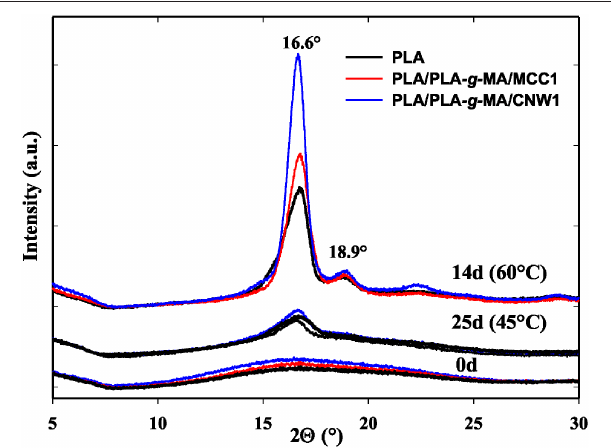
FIGURE 9 | WAXS patterns of PLA, PLA/PLA -g- MA/MCC1, and PLA/PLA -g- MA/CNW1 fibers recorded before exposure and after 25 days at 45 and 14 days at 60 ◦ C in hygrothermal